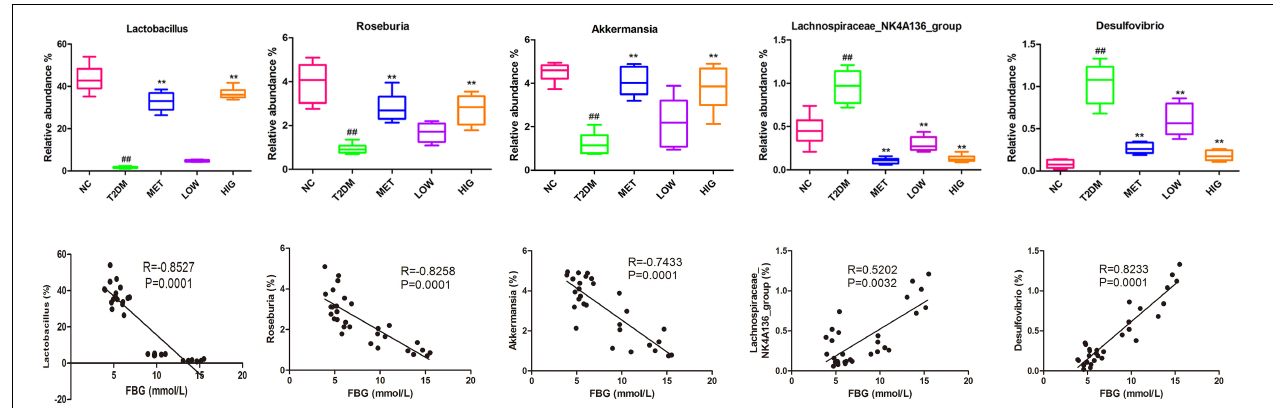
FIGURE 6 | Effect of RAGP treatment on the relative abundance (%) of gut microbial community at genus level and the correlation analysis between relative abundance of gut bacteria and FBG, including Lactobacillus, Roseburia, Akkermansia, Lachnospiraceae NK4A136 group, and Desulfovibrio. The relative abundance of gut microbial community was analyzed using QIIME and Tukey’s multiple comparison test. Values are mean ± SD, # P < 0.05, ## P < 0.01vs. NC group; ∗ P < 0.05, ∗∗ P < 0.01 vs. T2DM group.